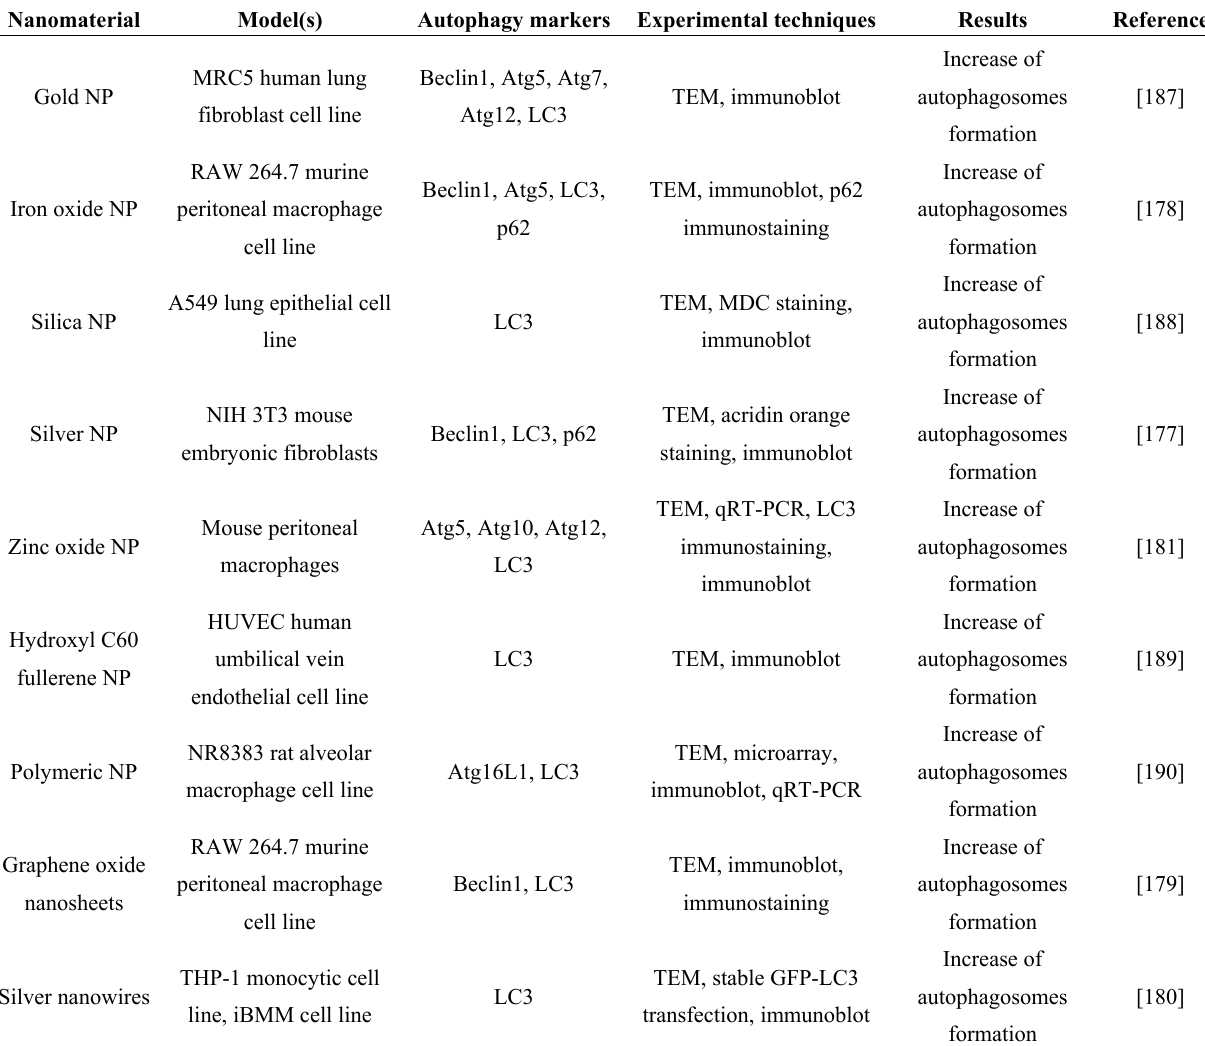
Table 1. A summary of nanomaterial-induced autophagy dysfunction in the literature: focus on autophagosomes